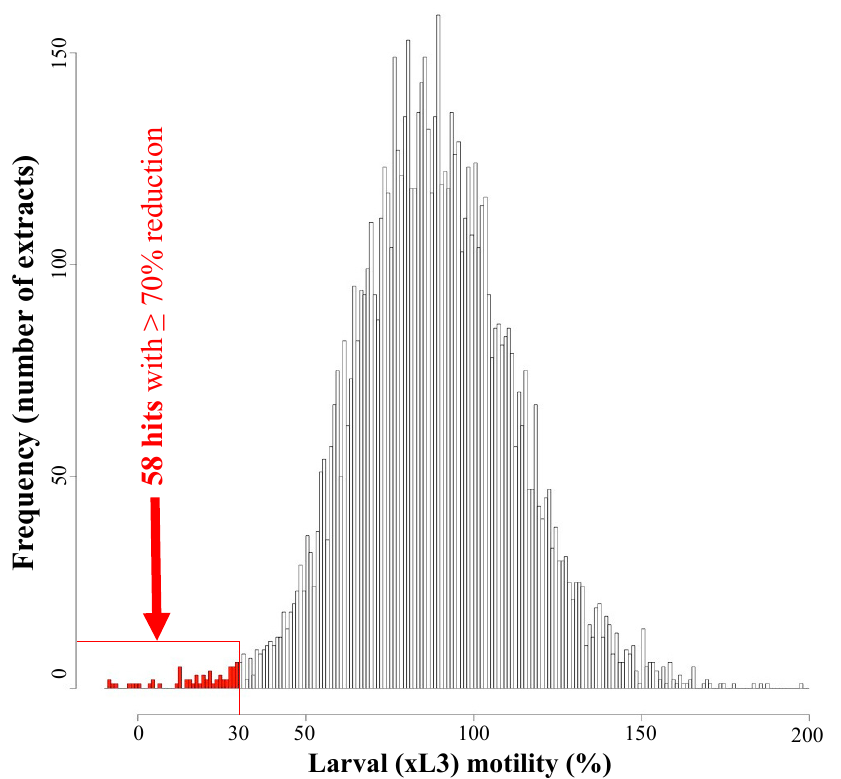
Figure 1. The distribution of the numbers of extracts according to the larval motility values obtained from the high throughput screen on exsheathed third-stage larvae (xL3s) of Haemonchus contortus. Of the total number of 7616 extracts individually tested at 3 µge/µL, 58 of them (~0.8%) reduced larval motility by ≥ 70% and were, thus, designated as ‘hits’. Motility values were normalised against those of positive- (monepantel) and negative- (no-extract/compound) controls.